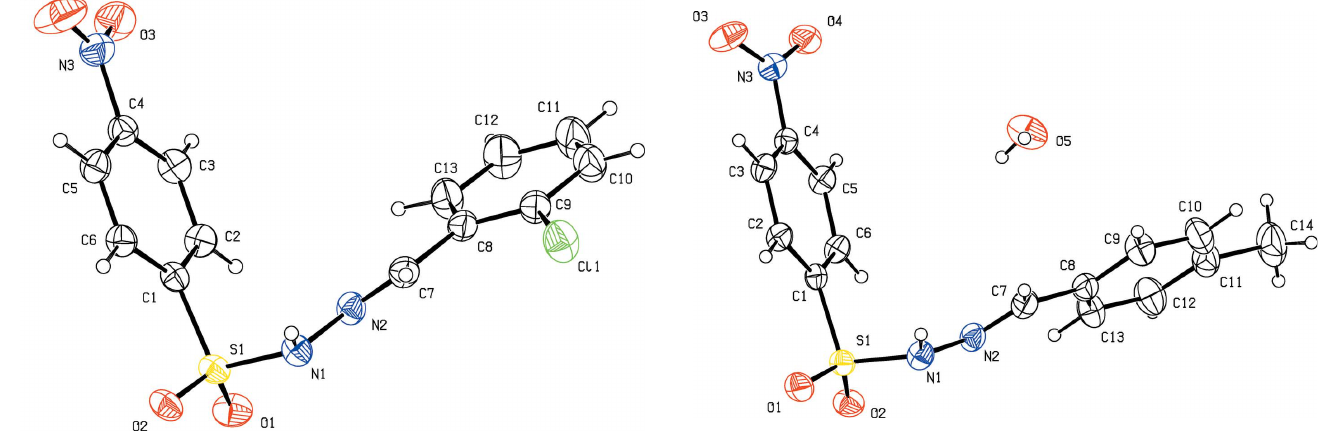
Figure 1 Molecular structure of compound (I), showing the atom labelling and displacement ellipsoids drawn at the 30% probability level.